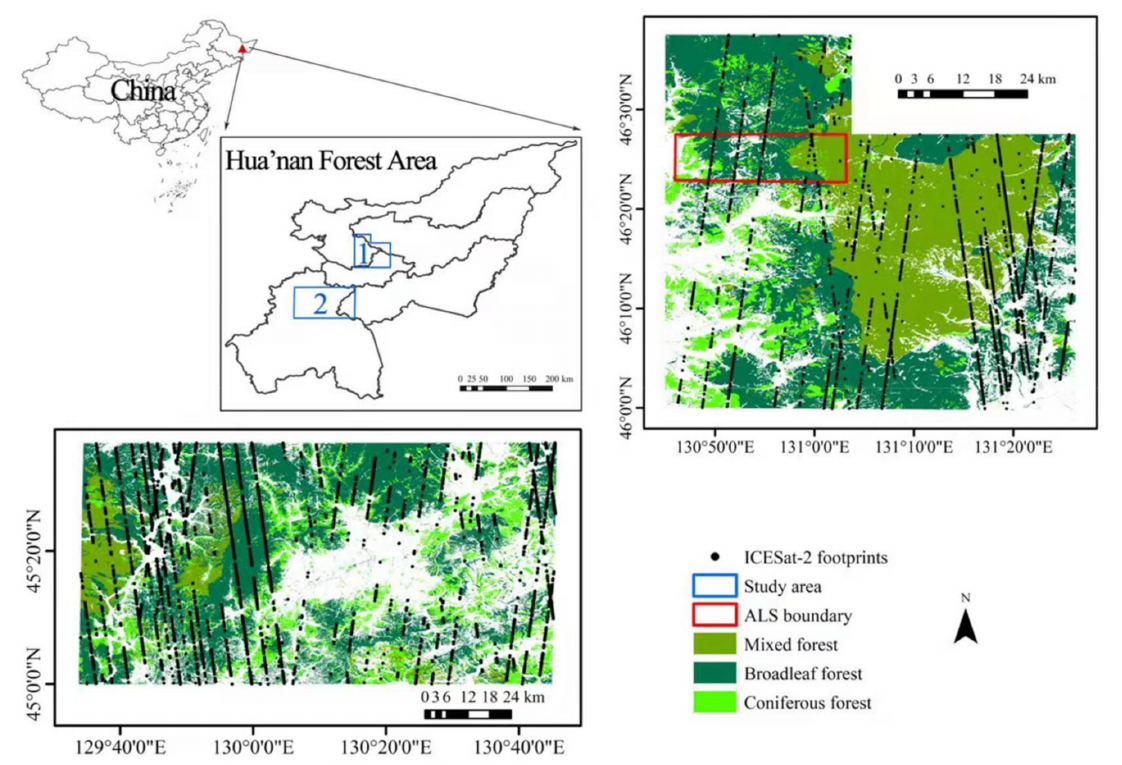
Figure 1. ICESat-2 footprints in Area 1 and Area 2, and distributions of coniferous forest, brodleaf forest, mixed forest in two study areas. (The blue polygon and rectangle denote study areas. The foot- prints of ICESat-2 are depicted by black dots. The red rectangle denotes the ALS data coverage